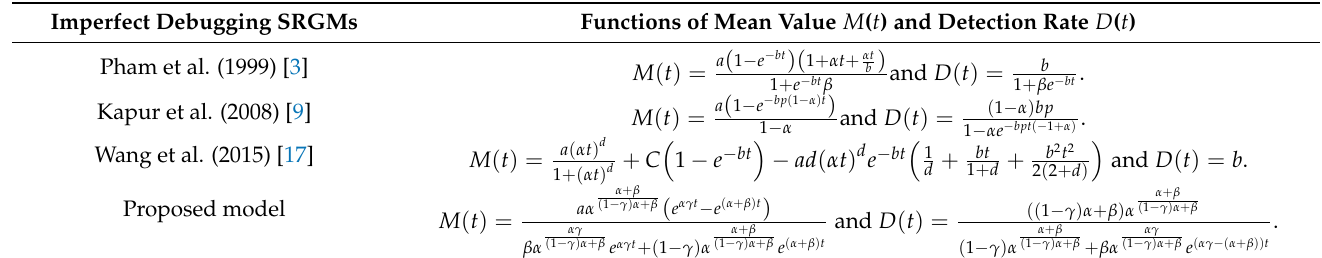
Table 3. Mean value functions and error detection rate functions for the imperfect debugging SRGMs. Imperfect Debugging SRGMs Functions of Mean Value M ( t ) and Detection Rate D ( t